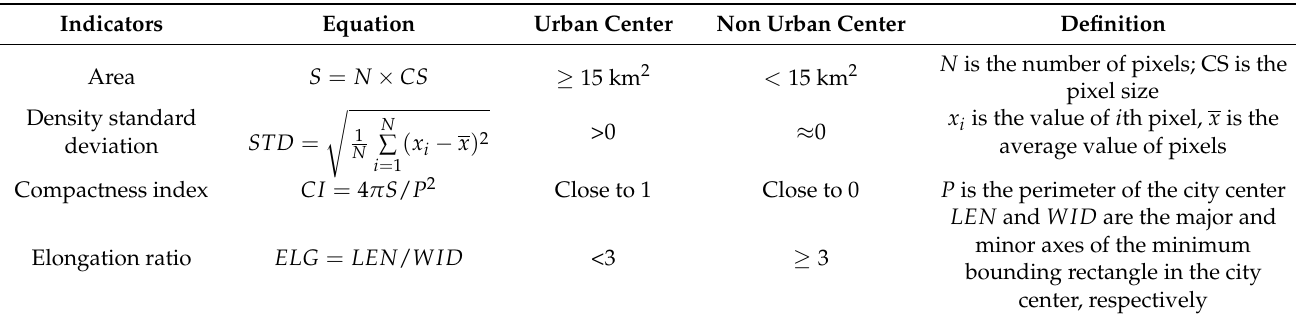
Table 2. Urban center identification